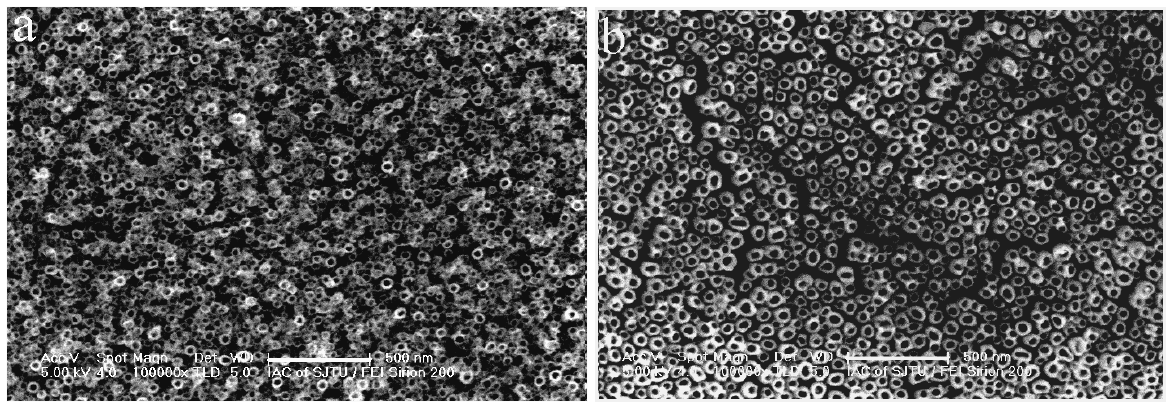
Figure 2. Top view and cross section images of as-anodized Ti-Ni-O nanostructures fabricated at different pulse voltages in a non-aqueous electrolyte of 5% ethylene glycol/glycerol containing 0.30 M (NH ) SO and 0.2 M NH F, ( a ) 30 V; ( b , c ) 40 V; ( d ) 50 4 2 4 4